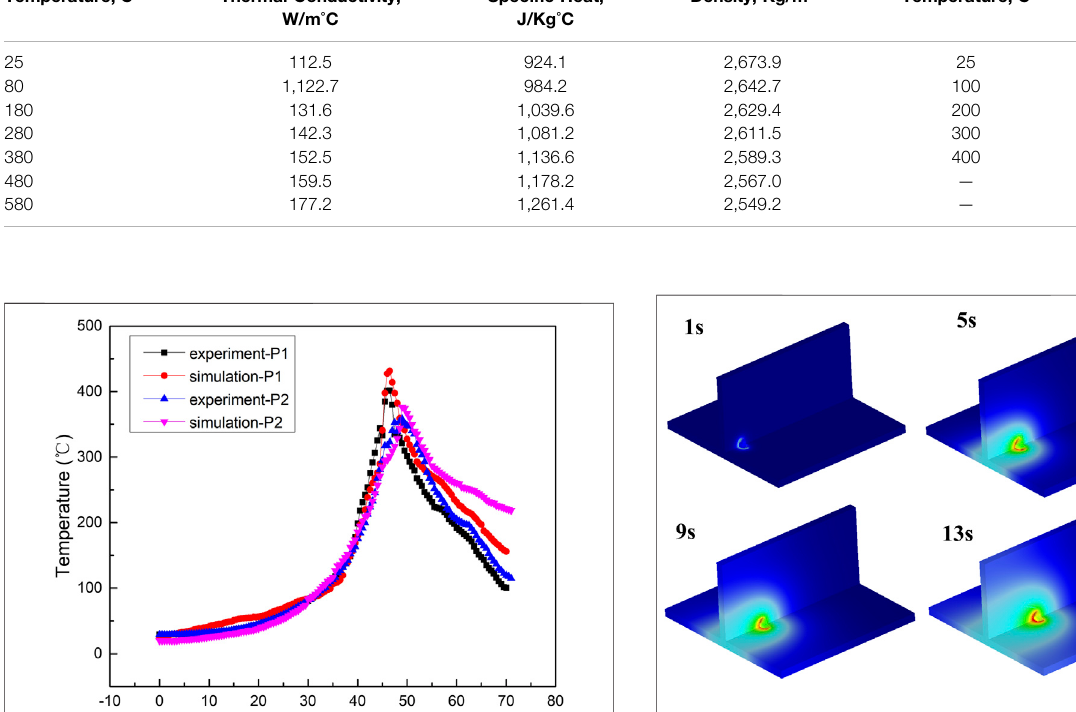
FIGURE 5 | Temperature distribution at different time during the process.